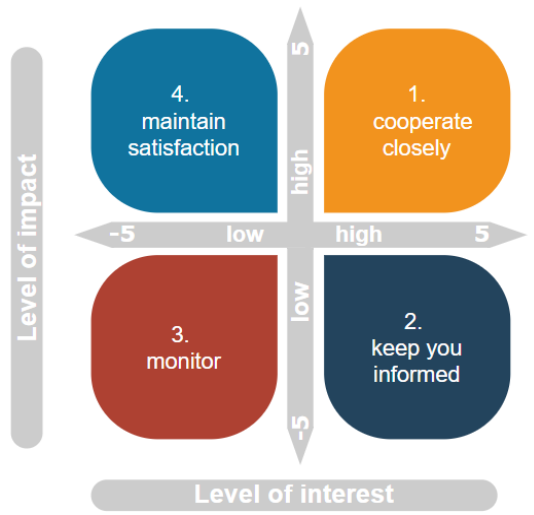
Figure 4. G. Johnson’s and K. Scholes’s matrix. Source: the authors’ own study based on [28]. The G. Johnson’s and K. Scholes’s matrix has a scale ranging from − 5 to +5 on both axes showing the level of interest and the level of impact, respectively, where − 5 means no impact or interest of any kind and +5 means a high level of impact or